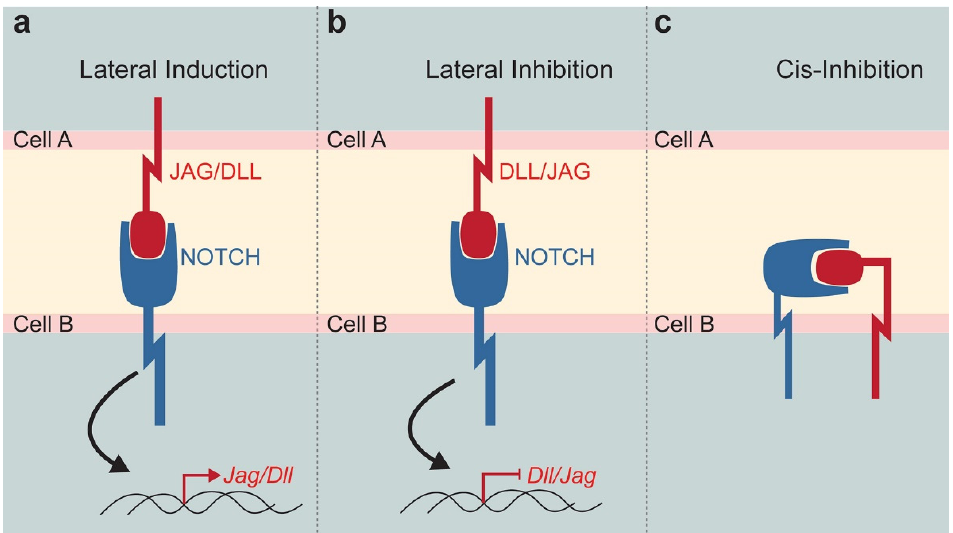
Figure 1 . Schematic representation of the Notch signalling function. Notch pathway modulation strongly depends on the Notch receptor – DLL/JAG ligand interaction established between neigh- bouring cells. ( a ) Lateral induction triggers the expression of the Jag or Dll in the receiving cell. ( b ) Lateral inhibition reduces the expression of Dll or Jag in the neighbouring cell. ( c ) Cis-inhibition occurs when receptor and ligand expressed by the same cell, activates the pathway and sequesters active molecules on a single cell surface. Abbreviations: DLL, Delta-like; JAG,